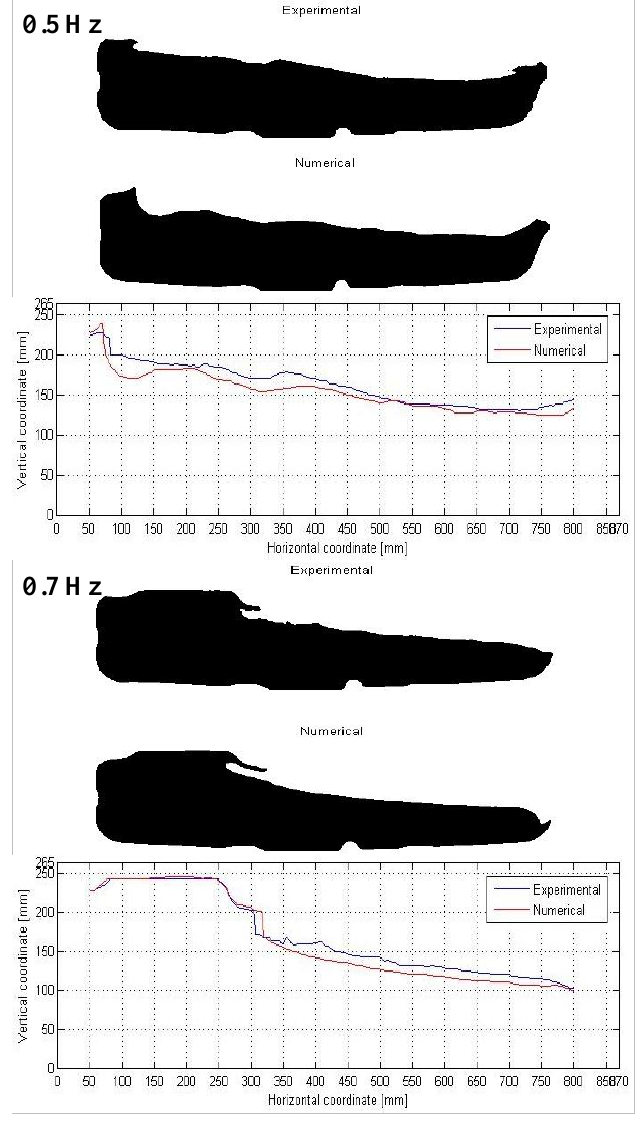
Figure 18. 2D Comparison of the free surfaces—numerical vs. experimental data.